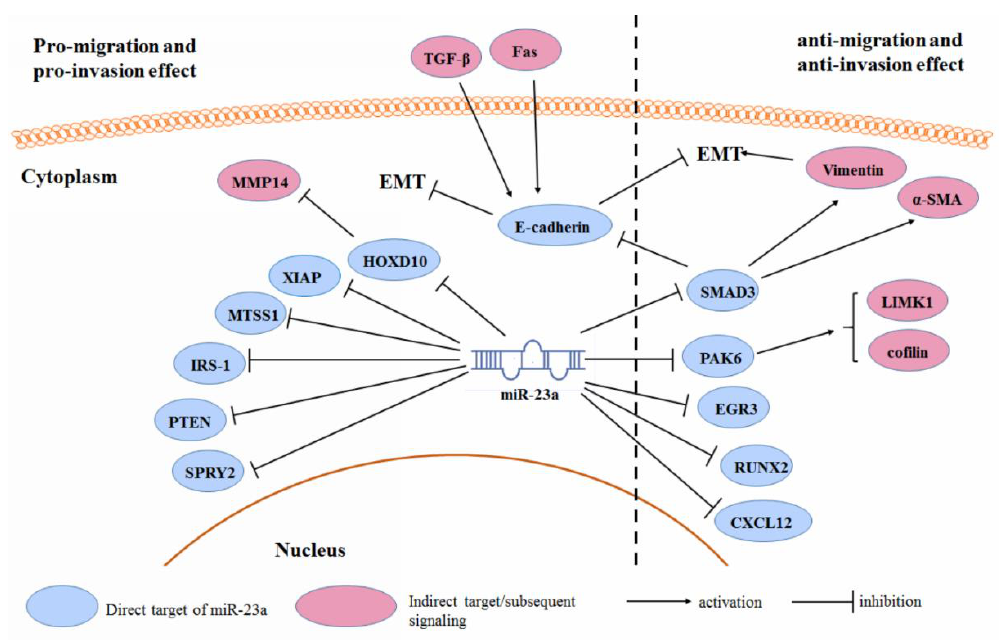
Figure 3. Regulation of the miR-23a on cancer cell migration and invasion.